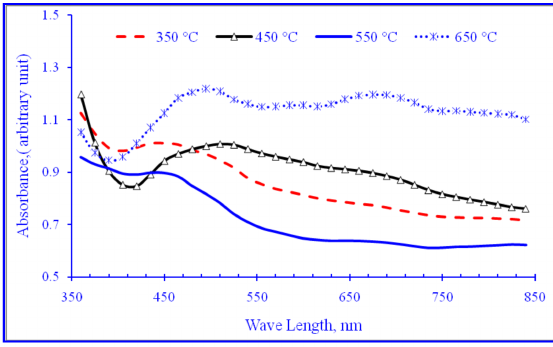
Figure 6. UV-Vis diffuse reflectance absorbance of TiO 2 annealed at different